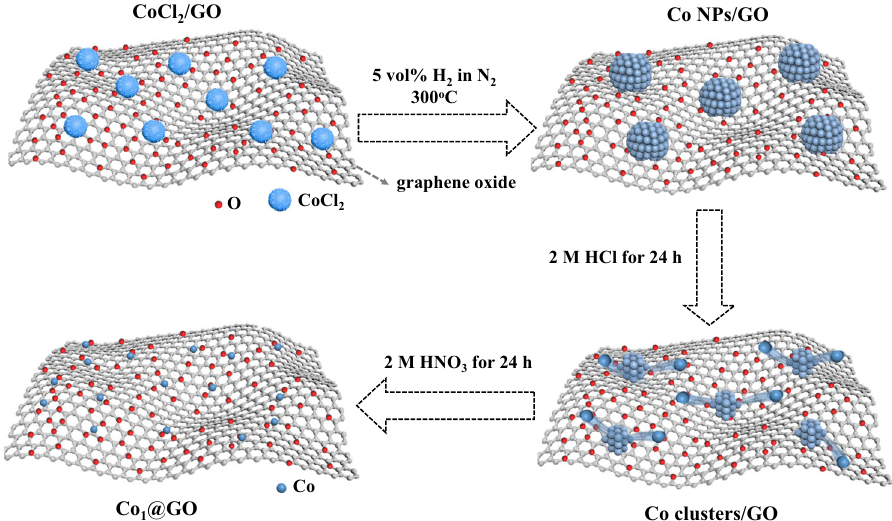
Fig. 1 Schematic of synthesis of Co 1 @GO. Co nanoparticles were fi rstly prepared via reducing CoCl 2 in 5 vol% H 2 in N 2 (Co NPs/GO). Co NPs/GO was leached to form Co 1 @GO.